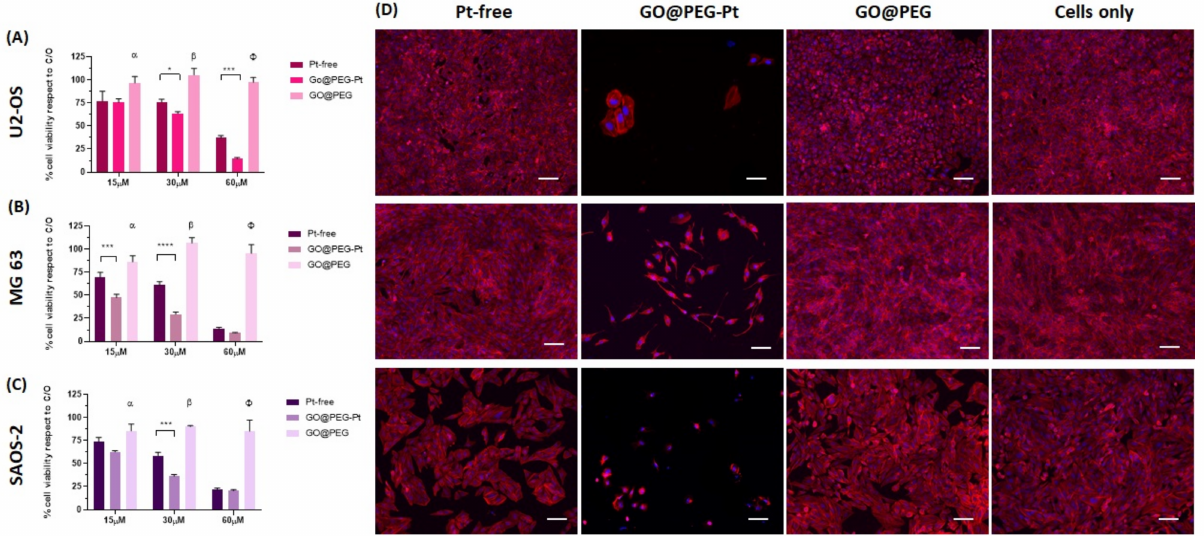
Figure 4. Cell viability and morphological analysis in osteosarcoma cell lines. An MTT assay was performed after 72 h of cell culture. The data show the percentage of viable cells compared to cells alone as the control, and the mean ± standard error of the mean is presented. The graphs show the viability of the U2-OS cell line ( A ), the MG63 cell line ( B ), the SAOS-2 cell line ( C ) and the respective morphological images of the cells cultured for 72 h in the presence of the 30 mM concentration. Phalloidin red stains for actin filaments, and DAPI blue stains for cell nuclei ( D ). Scale bars: 100 µ